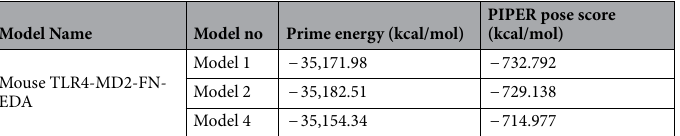
Table 2. Prime energies and PIPER scores of the low RMSD models obtained for mouse TLR4-MD2-FN- EDA docked complexes. Prime Energy, Overall energy of the entire docked complex of TLR4-MD2-FN-EDA using Schrödinger Prime module; PIPER score, Pose score of the top scoring entry obtained for TLR4-MD2- FN-EDA docked complex from Schrödinger BioLuminate (performs protein–protein docking using PIPER